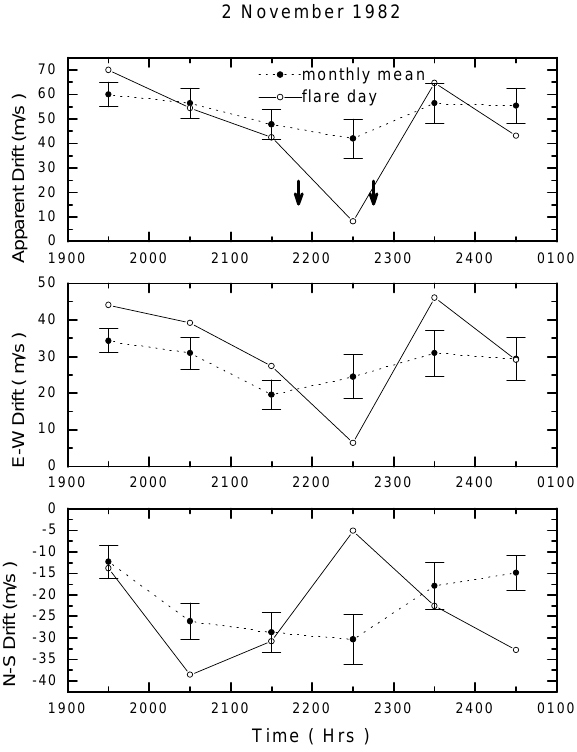
Fig. 5. Variation of Apparent Drift Speed, its E–W and N–S com- ponents on 2 November 1982, along with their respective monthly mean variation. The solar flare occurred at 21:50 and 22:45 (1N). The rest of the details are the same as in Fig. 1.